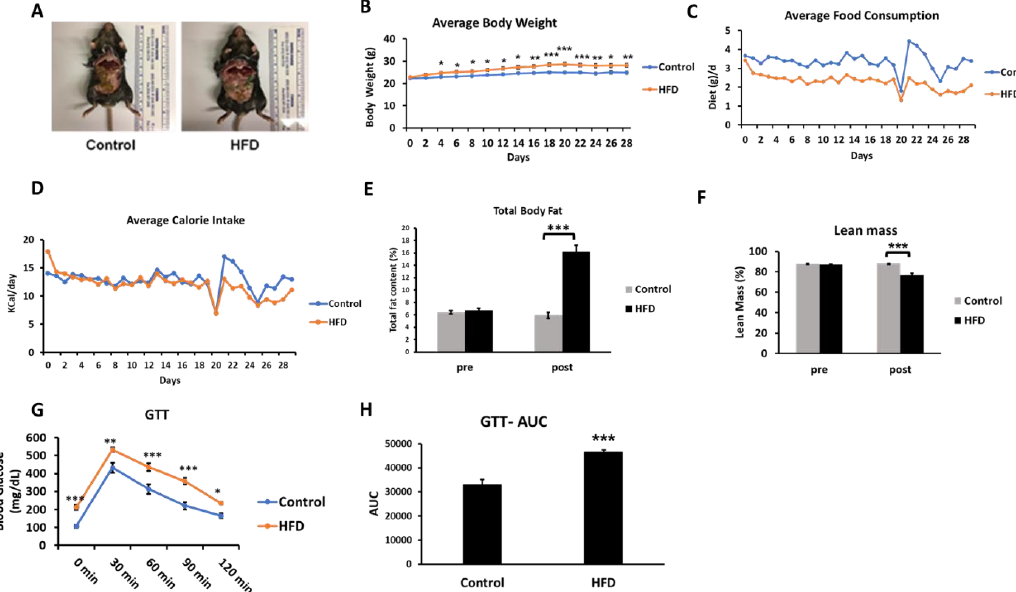
Figure 2. Effects of an HFD in wild-type C57BL/6J male mice at four weeks of feeding (n = 6–7/group). A , Representative images of mice fed either the control or HFD. B , The change in average body weight over the duration of the study in the control and HFD-fed mice. C and D , The average daily food consumption and calorie intake in the control and HFD-fed mice. E and F , Analysis of total fat content and lean mass percentage in mice recorded at the start of the study (pre) and on the day of sacrifice (post) using EchoMRI body composition analyzer. G and H , The time course and the area under the curve (AUC) of the glucose tolerance test (GTT) in the mice after intraperitoneal injection of glucose following an eight-hour fast. Results are mean ± SEM. Statistical significance, * indicates p < 0.05, ** indicates p < 0.01, and *** indicates p < 0.005 compared to control.